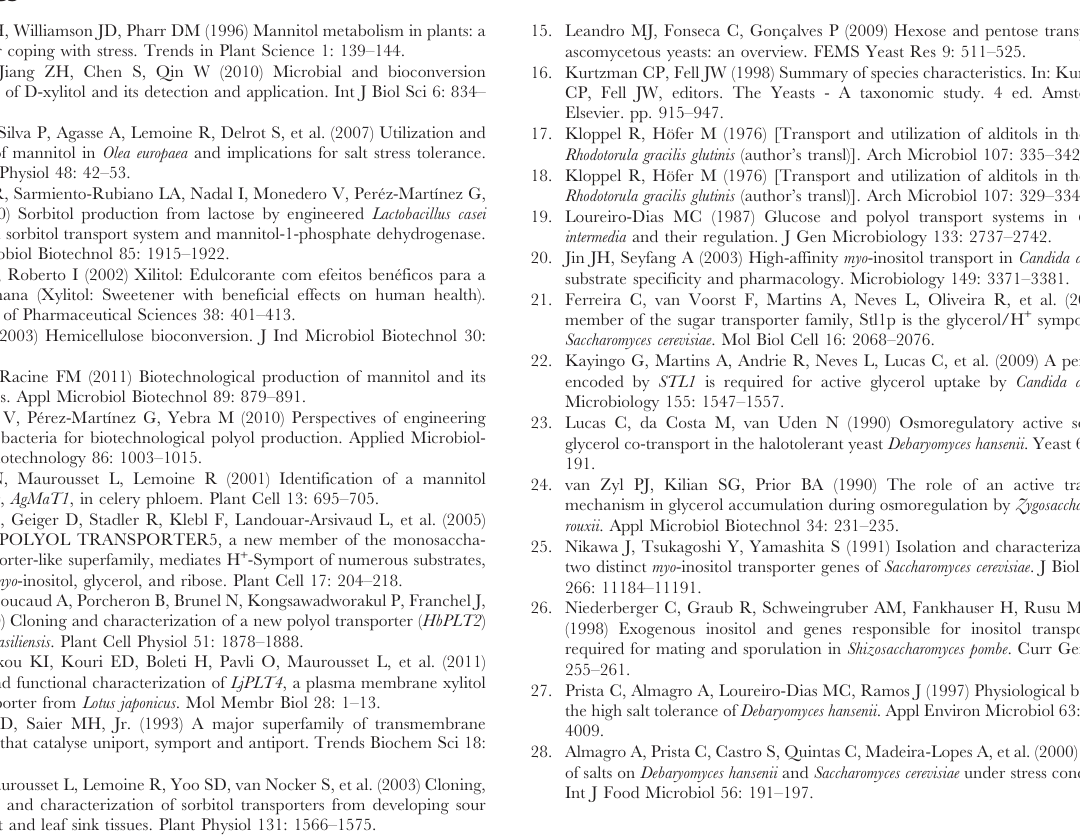
Table S1 Occurrence of CUG codons in D.